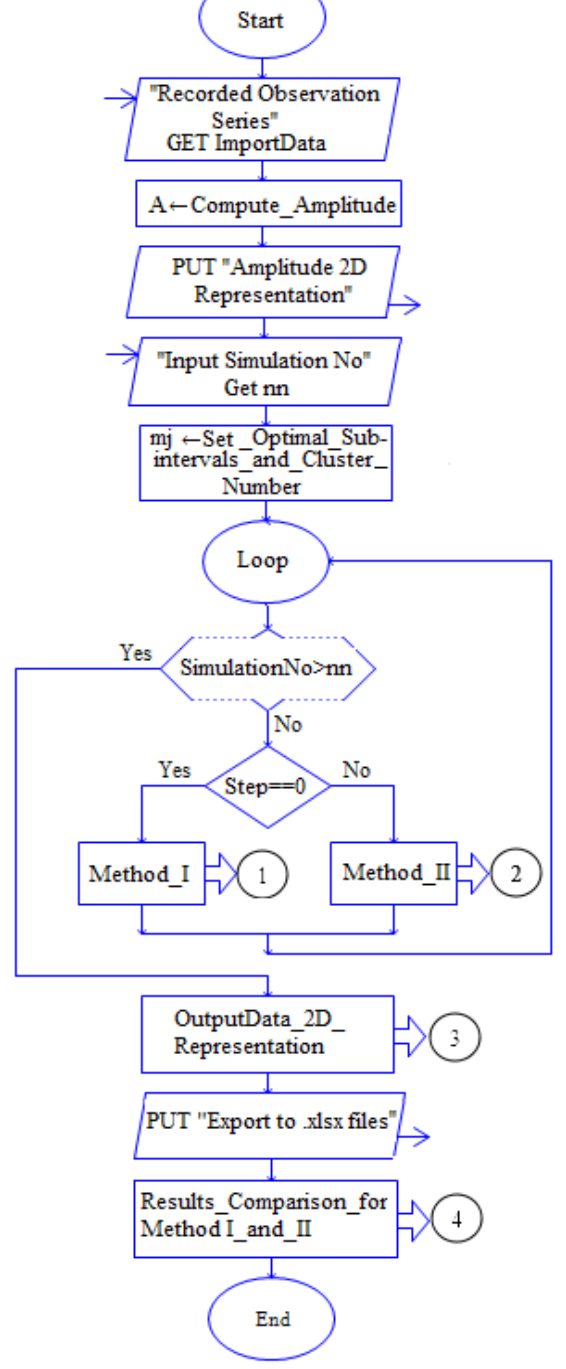
Figure 2. The algorithm flowchart .